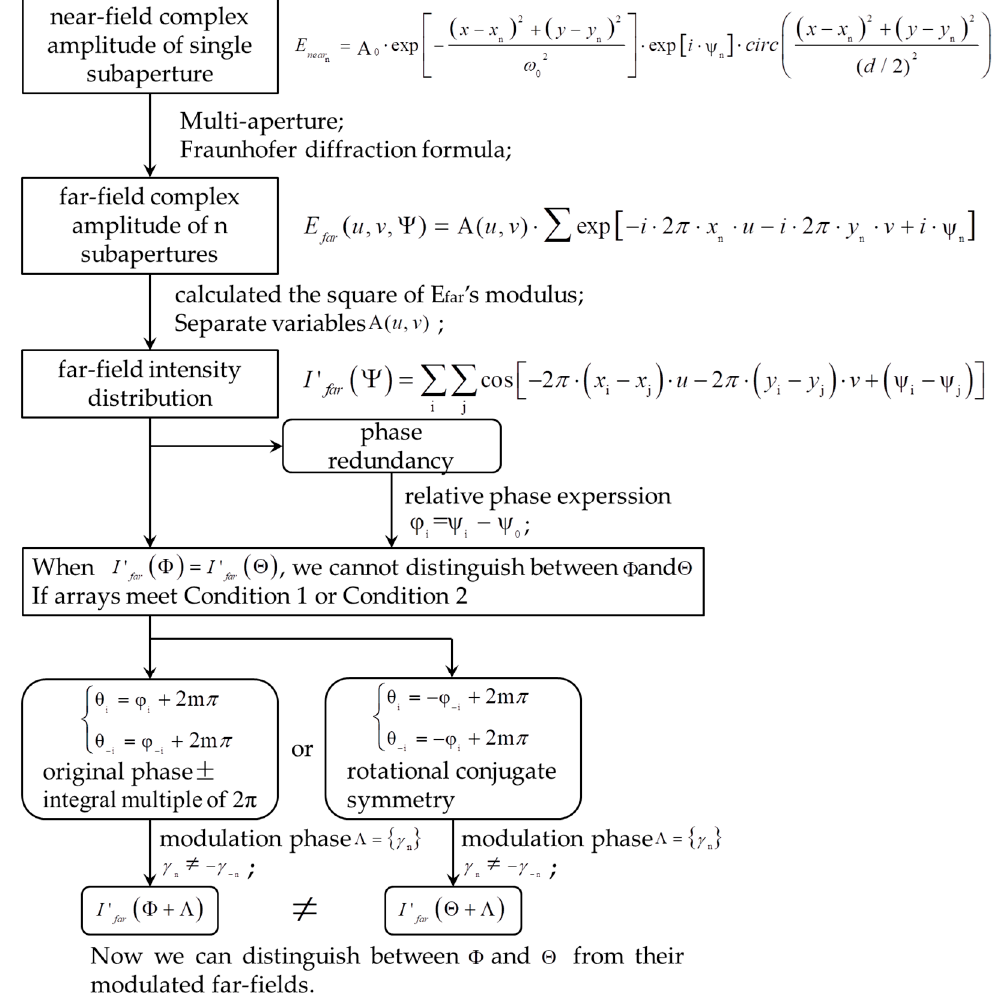
Figure A2. The process of our main derivations.